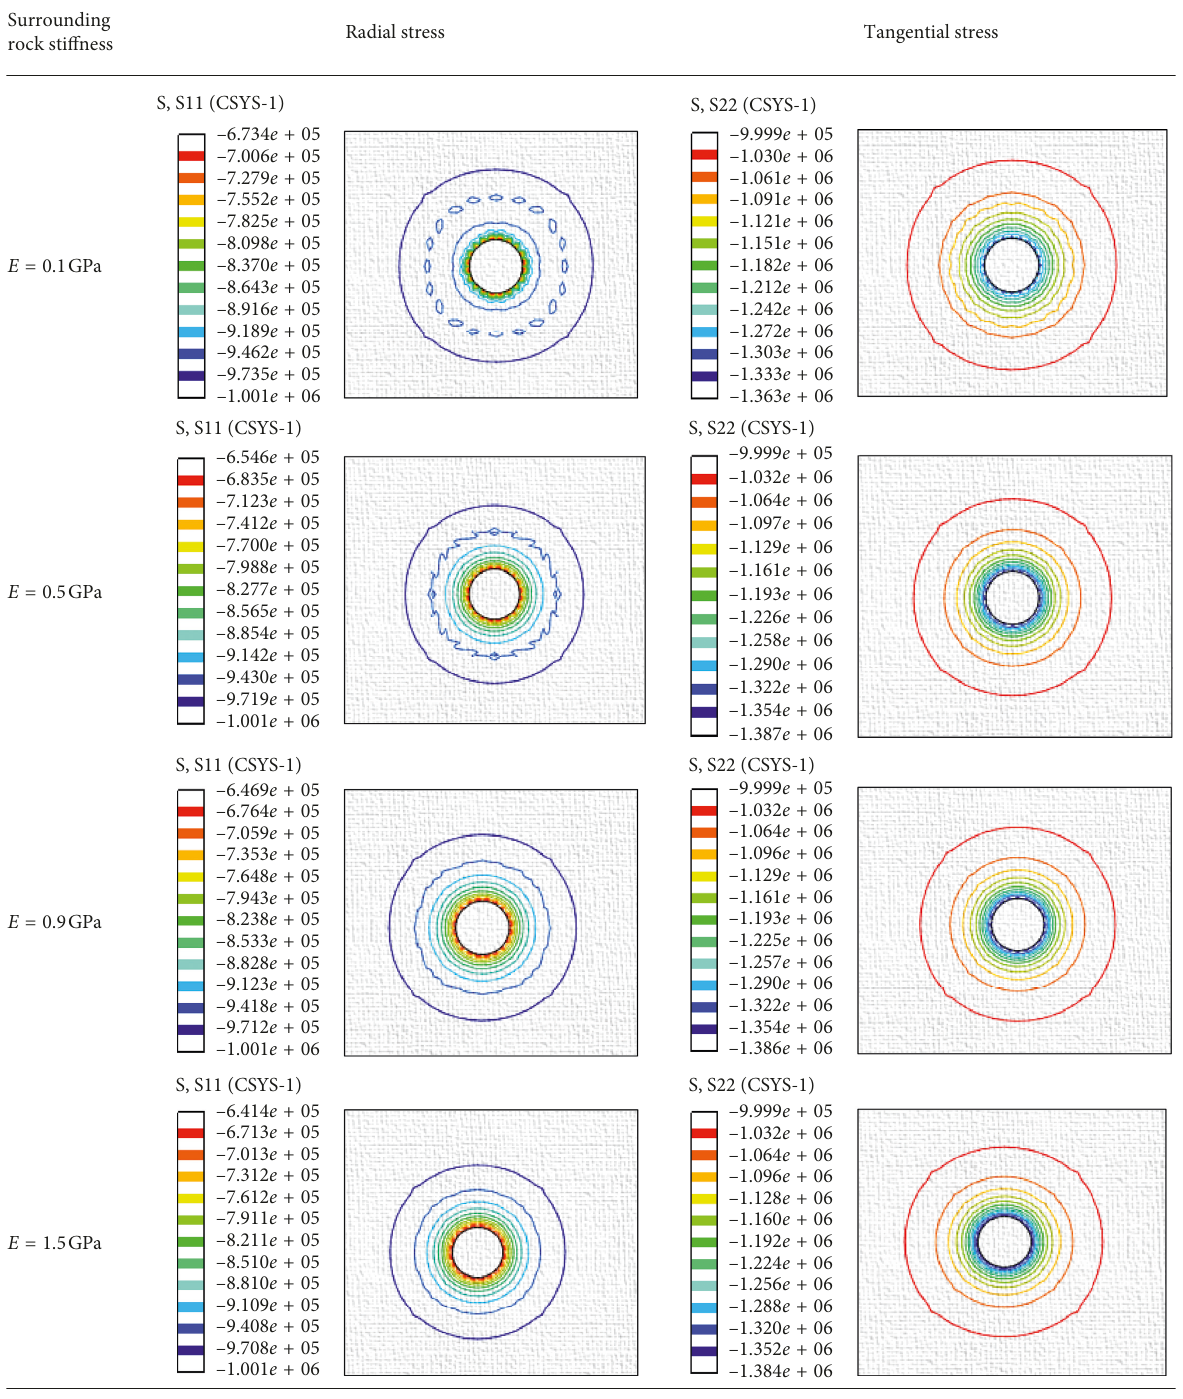
Figure 15: Distribution of stress with different surrounding rock stiffness ( α �